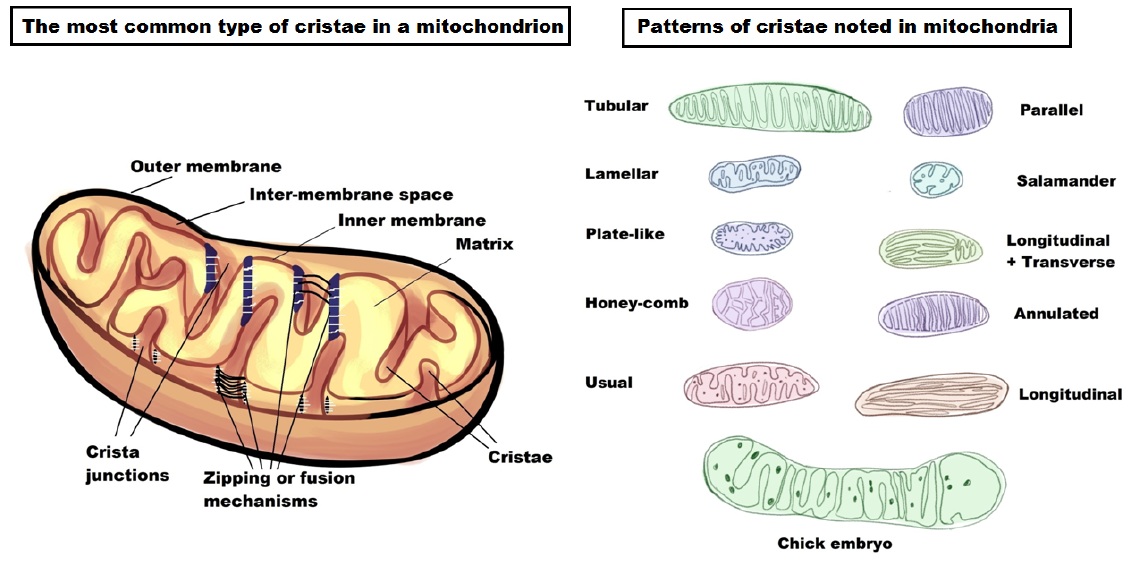
Figure 3: The spatial arrangement of MICOS complex needed for Wolf et al proposals to realize in common mitochondrial cristae, along with some other types of